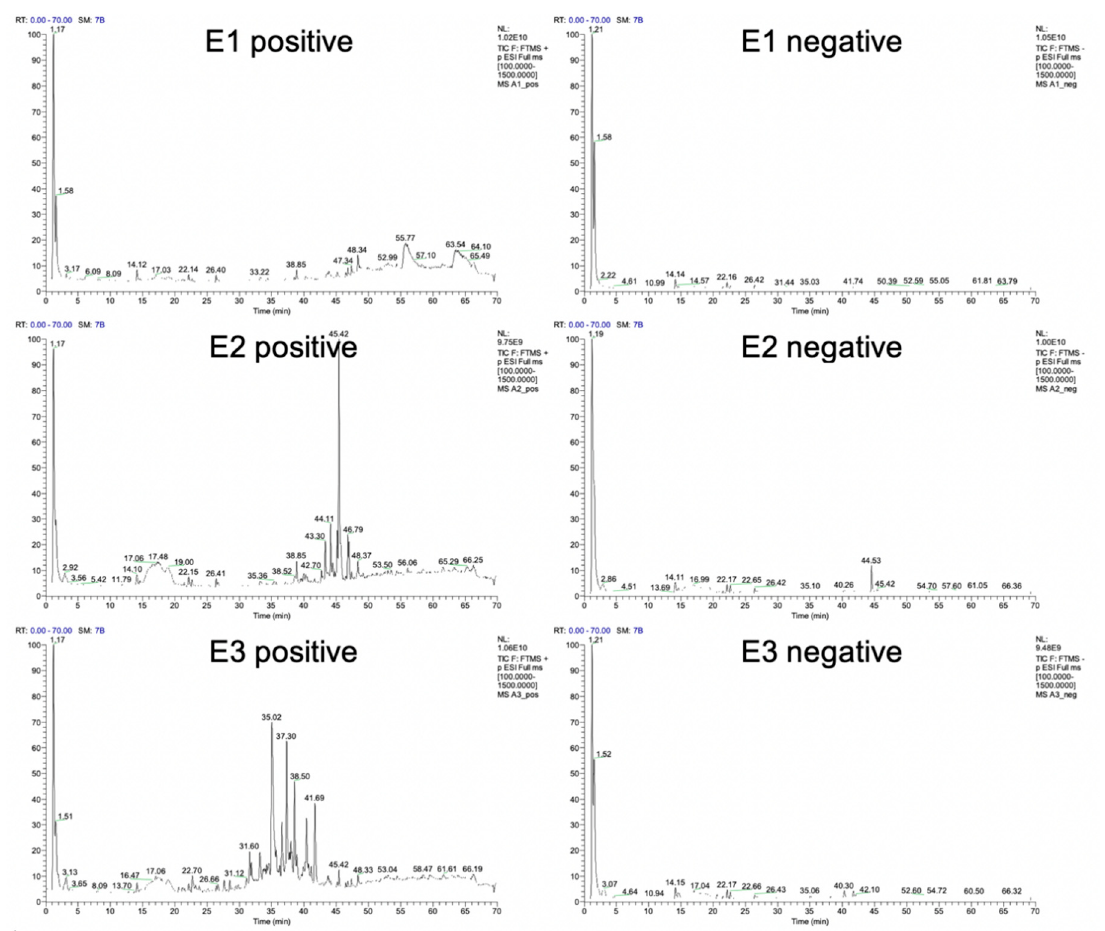
Figure 1. Ion chromatograms in positive and negative mode obtained using UHPLC-ESI-MS/MS.